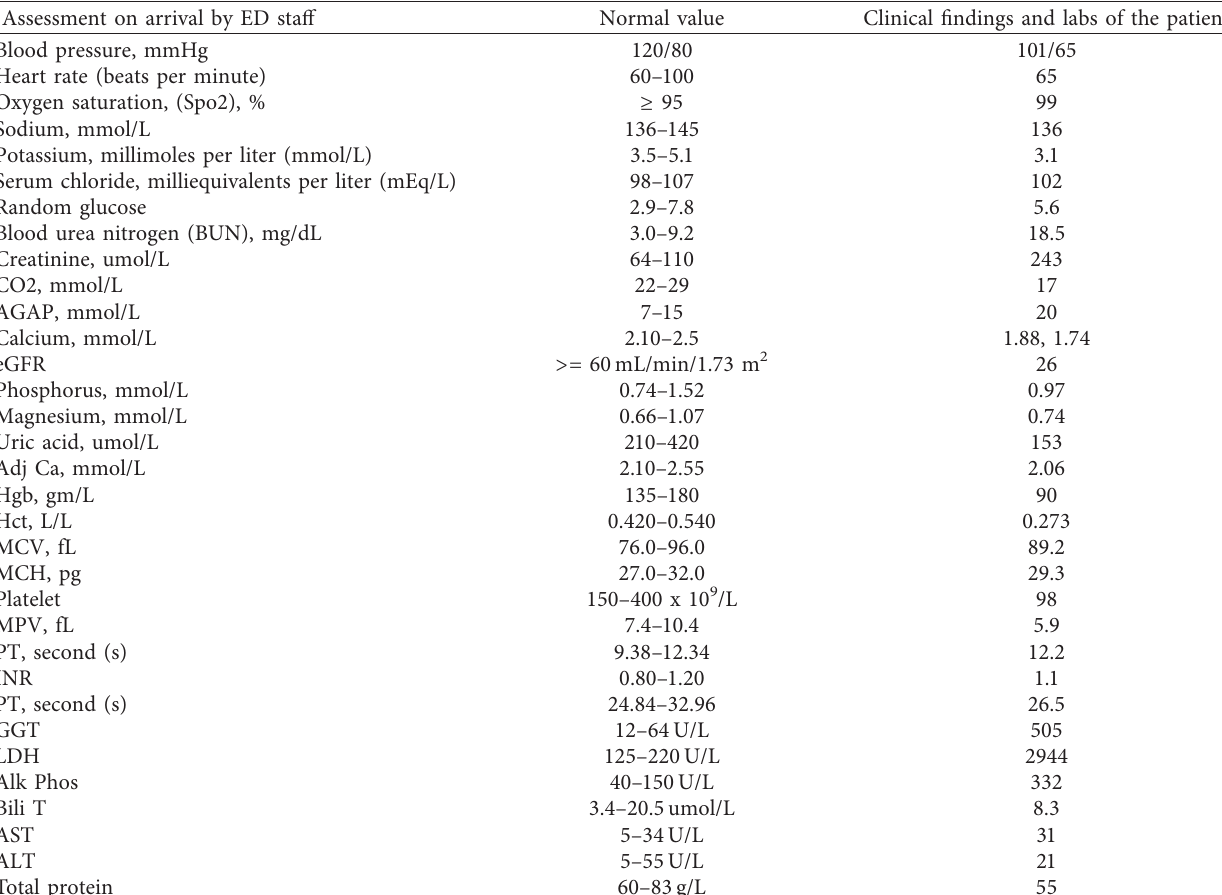
Table 1: Clinical findings on admission to the Emergency Department (ED) of the